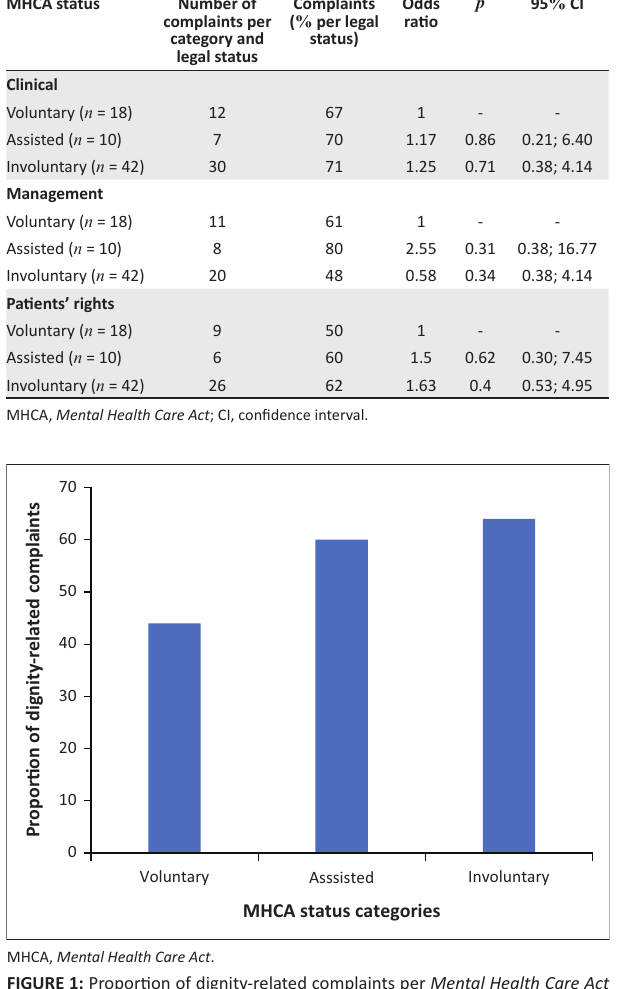
TABLE 2: Association between Mental Health Care Act status and clinical, management and patients’ rights complaints. MHCA status